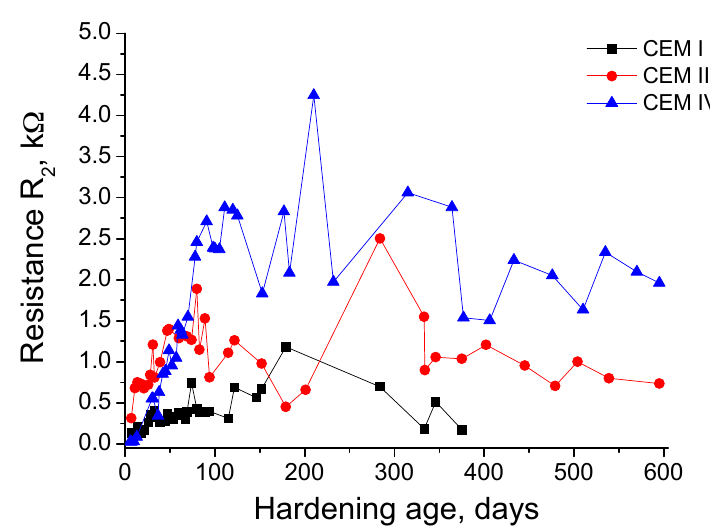
Figure 3. Results of resistance R 2 for CEM I, III and IV grouts.